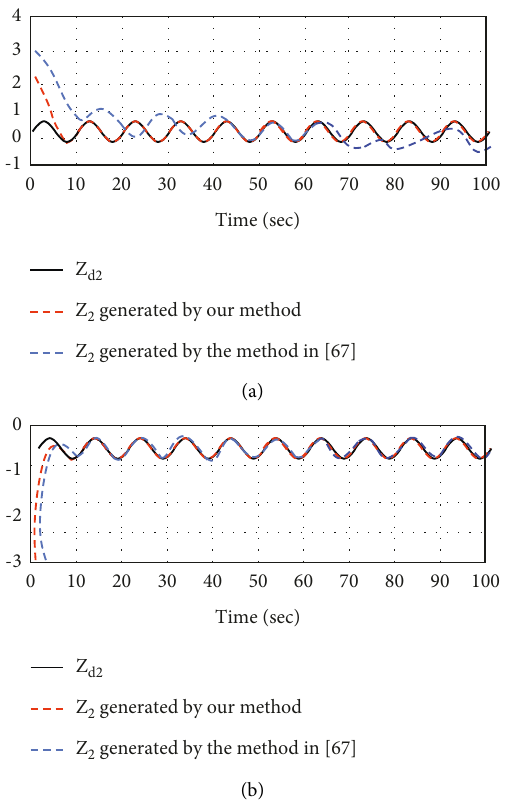
Figure 9: Tracking trajectory of the